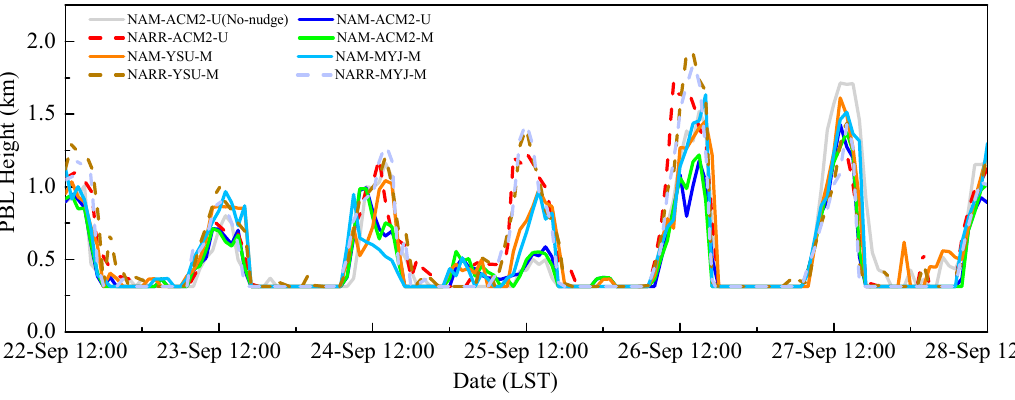
Figure 5. Hourly time series of PBL height (Mean Sea Level, MSL) of the observation site diagnosed by the bulk Richardson number (Ri b ) method. Atmosphere 2017 , 8 , 197